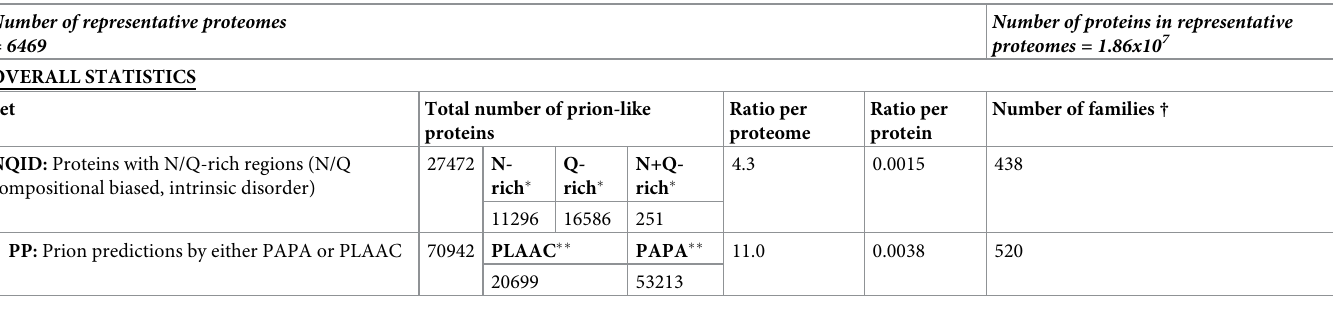
Table 1. Summary of data